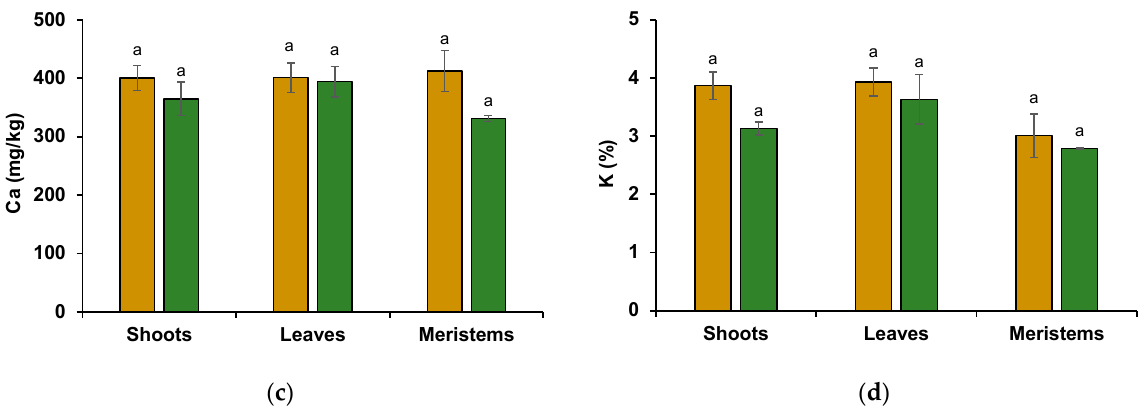
Figure 2. Concentrations of ( a ) Mn, ( b ) Mg, ( c ) Ca, ( d ) K, and ( a ) Mg/Mn ratio (line) in the shoots, leaves, and meristems of wheat grown for 3 weeks in acidic soil after the previous development of Lolium rigidum (LOL) (light brown) or Ornithopus compressus (ORN) (green). Different letters indicate statistically significant differences ( p < 0.05) on the basis of Tukey’s test.